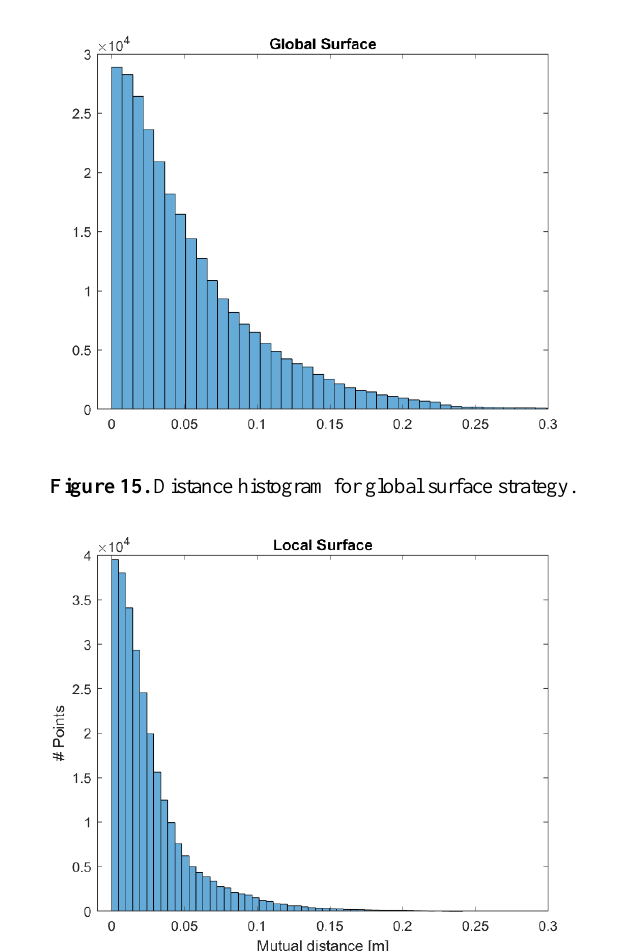
Figure 16. Distance histogram for local surface strategy.